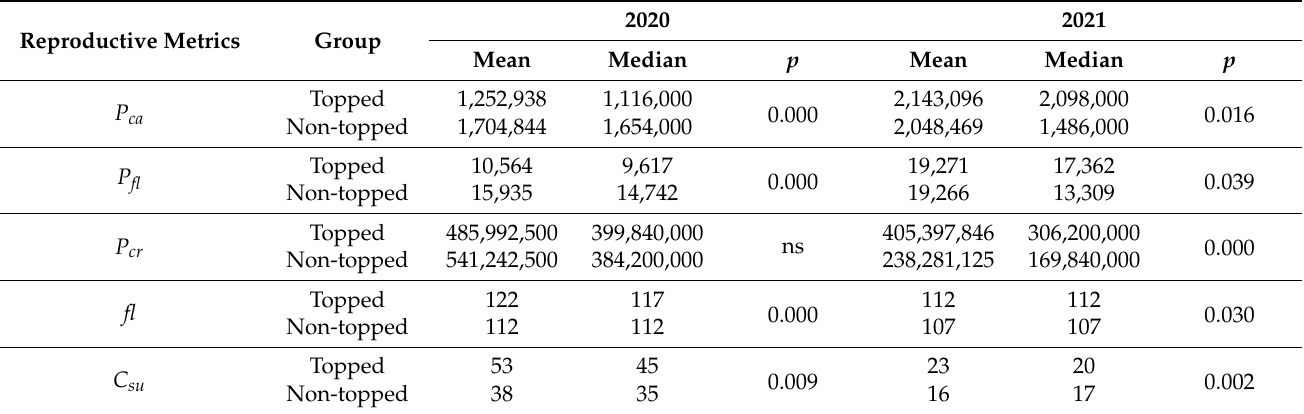
Table 4. Reproductive metrics (mean and median) of topped ( n = 12) and non-topped trees ( n = 16) in 2020 and 2021 and comparisons (Mann–Whitney U test) between them.